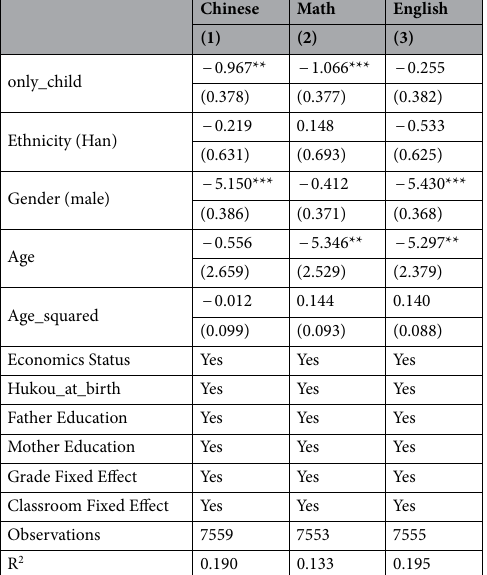
Table 8. The analysis using compliers as a sample. Notes: Standard errors in parentheses, adjusted for within- classroom clustering. * p < 0.10. ** p < 0.05. *** p < 0.01.